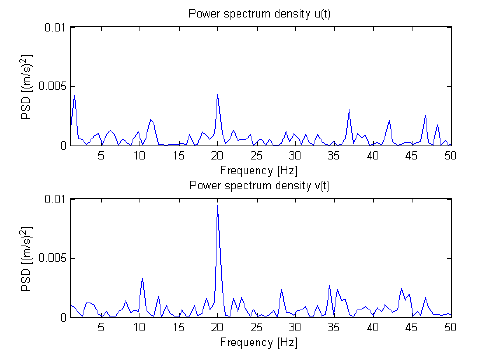
Fig. 10b. Phase angle ϕ=π . Frequency spectrum at point 3 for regime